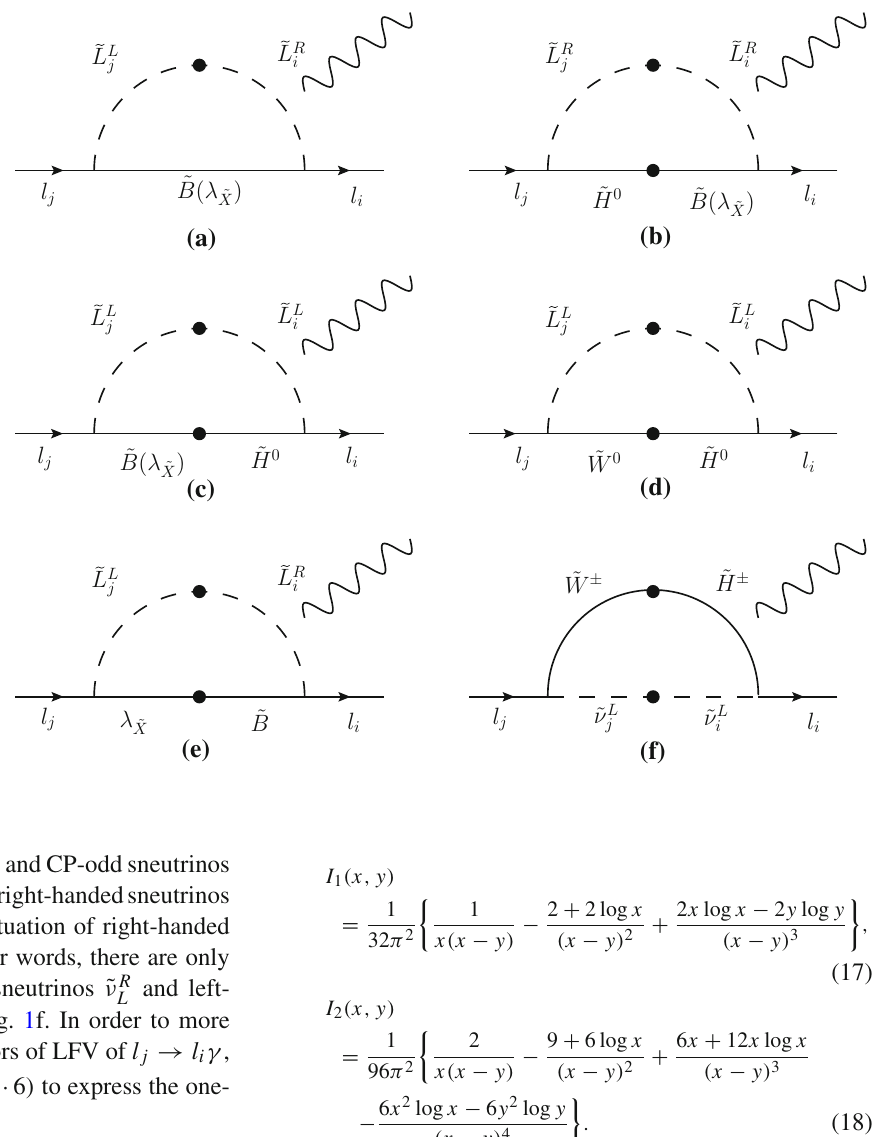
Fig. 1 Feynman diagrams for l j → l i γ in the